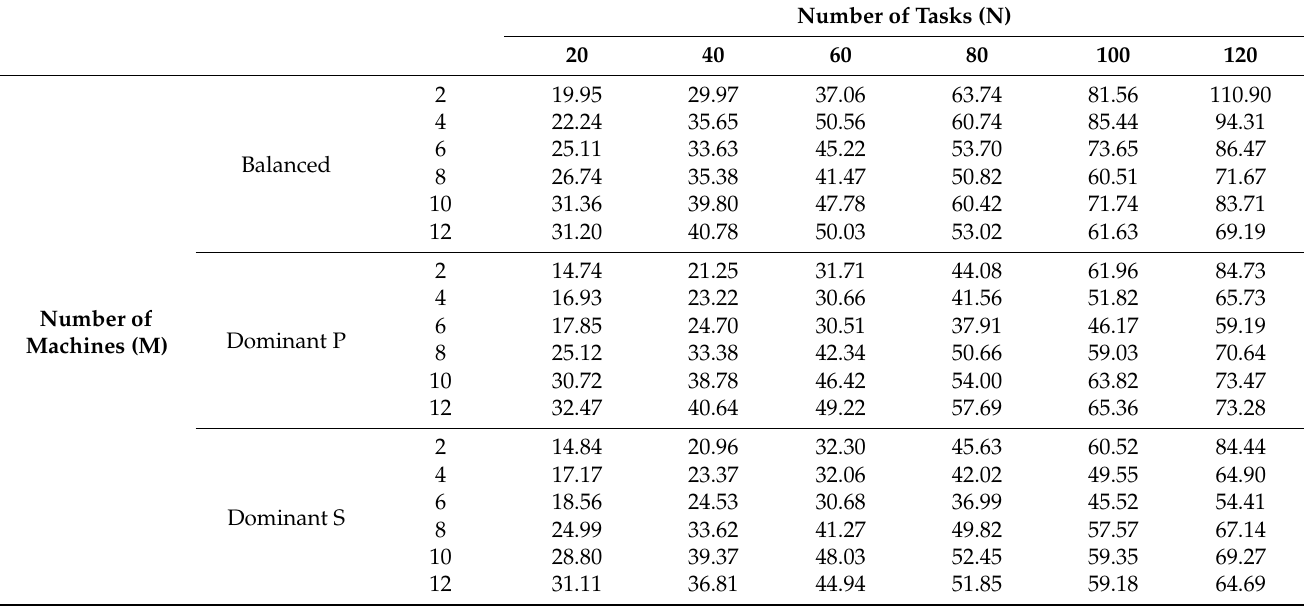
Table 6. Average GA execution time for Balanced, Dominant P, and Dominant S for large